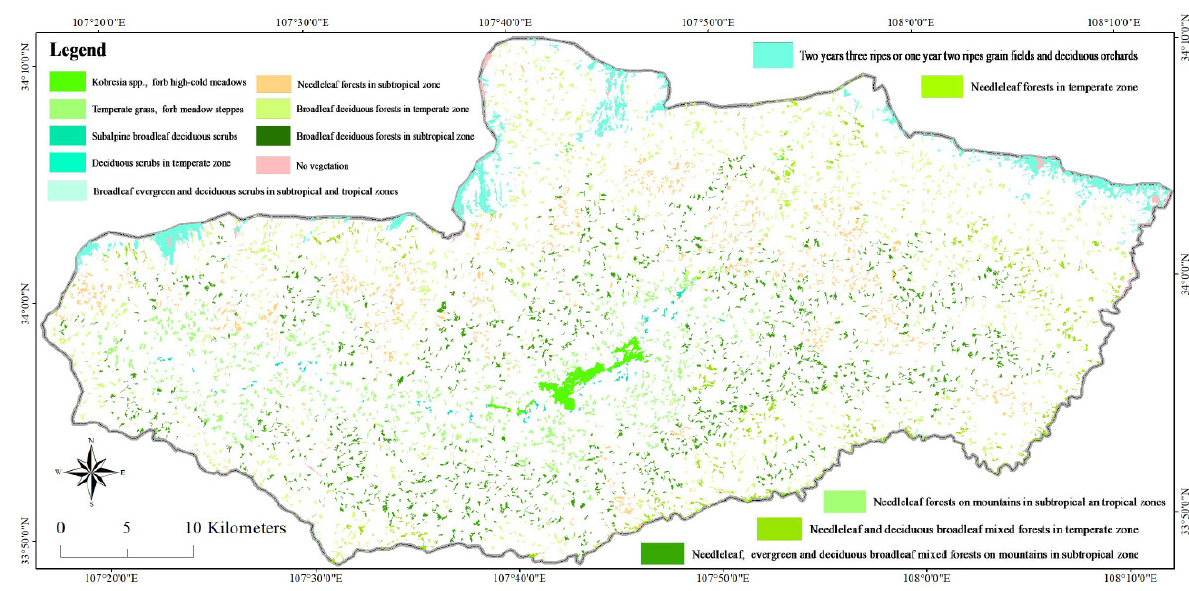
Figure 8. The distribution of collected geo-object samples according to the process of Figure 2. Table 3. Comparison of the accuracies achieved using different schemes in the sampling scheme.